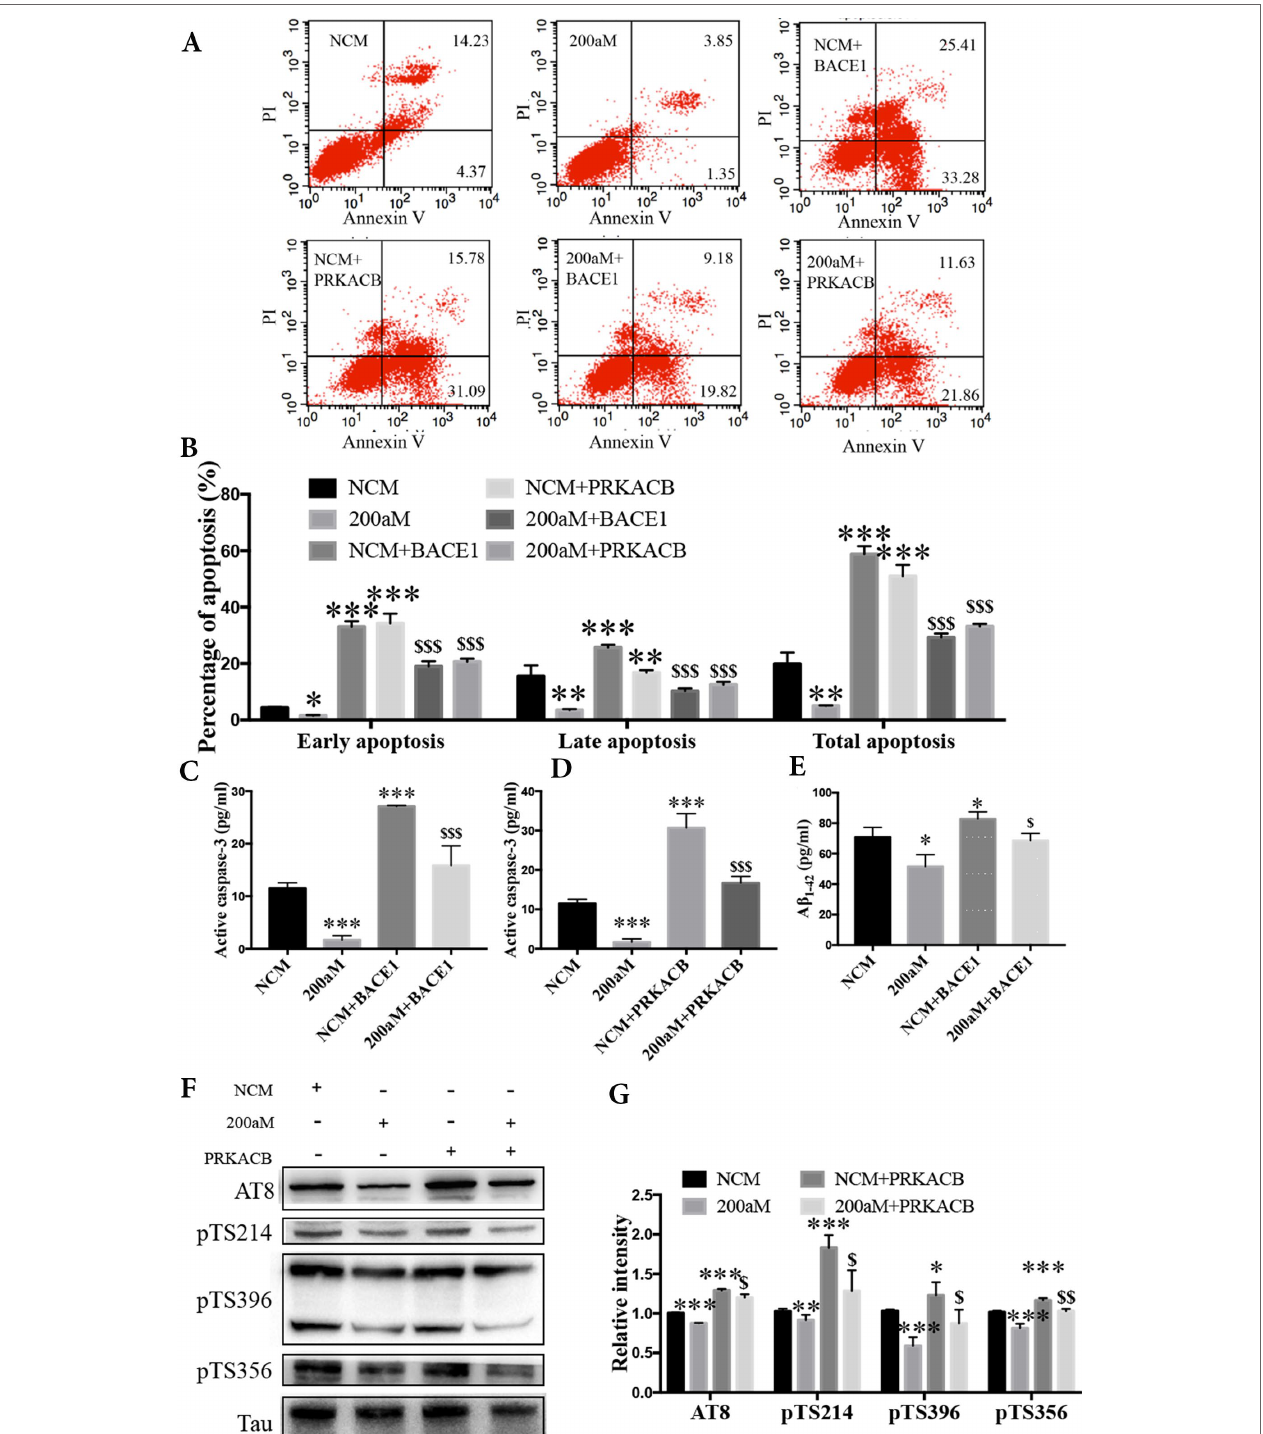
FIGURE 5 | Neuroprotection of miR-200a-3p by regulating the participation of BACE1 and PRKACB in A β overproduction and tau hyperphosphorylation, respectively, in APPswe cells. (A , B) Effects of miR-200a-3p, BACE1, and PRKACB overexpression on apoptosis of APPswe cells detected using flow cytometry assay (A) and demonstrated by quantitative analysis (B) ( n = 3). (C , D) The release of active caspase-3 in APPswe cells when miR-200a-3p and BACE1 (C) or PRKACB (D) overexpression measured using ELISA ( n = 4). (E) Effects of miR-200a-3p and BACE1 overexpression on the production of A β 1-42 peptides in a cell model of AD ( n = 4). (F, G) Effects of miR-200a-3p and PRKACB overexpression on tau phosphorylation at AT8, Ser214 (pTS214), Ser396 (pTS396), and Ser356 (pTS356) sites in APPswe cells, as demonstrated by representative images (F) and quantitative analysis (G) by Western blotting ( n = 3). Data are shown as the mean ± SEM. *P < 0.05, ** P < 0.01, ***P < 0.001 versus NCM. $ P < 0.05, $$ P < 0.01, $$$ P < 0.001 versus